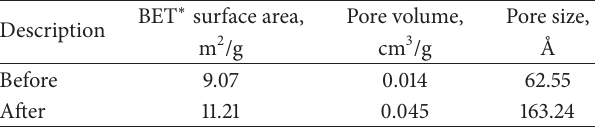
Table10:Valuesofsoilsurfaceareaandporevolumeandsize,before and after treatment.